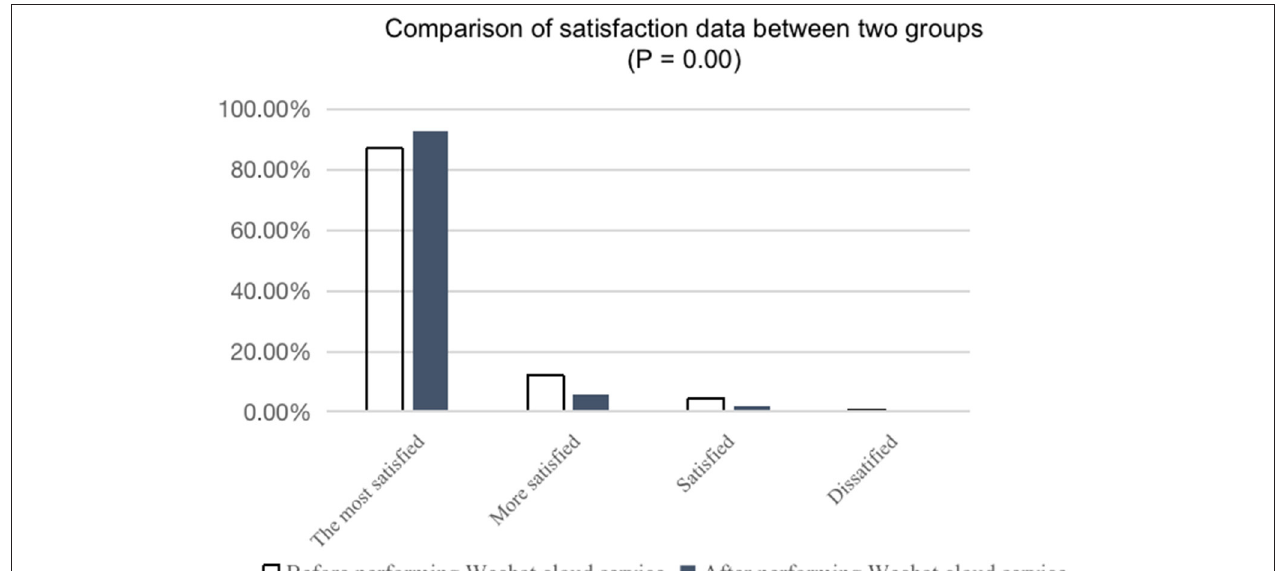
FIGURE 1 | Comparison of “satisfaction” data between the two groups.